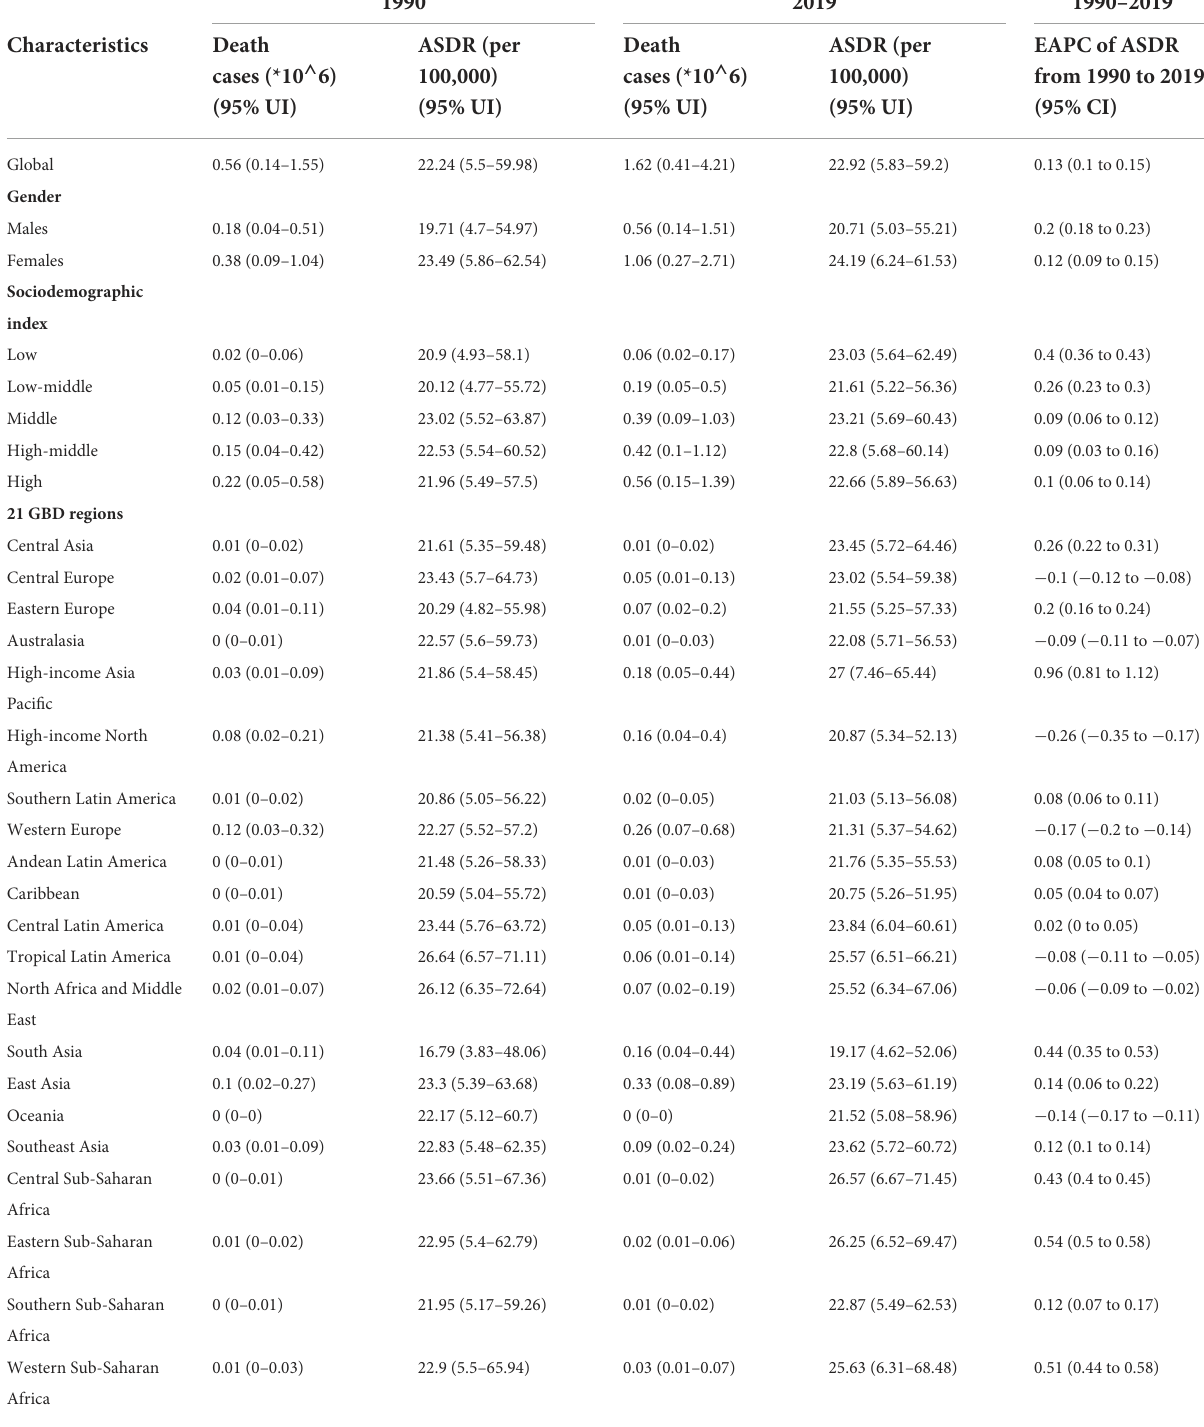
TABLE 3 The number of deaths and ASDR of Alzheimer’s disease and other dementias in 1990 and 2019 and its